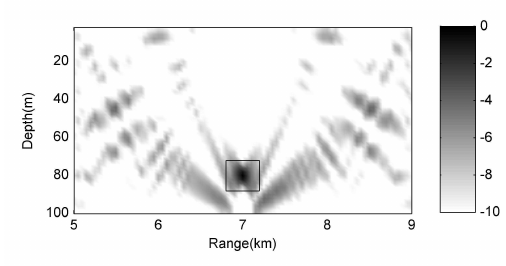
Figure 3. Bartlett ambiguity surface of 1# large array. The target in the rectangle is the localization result, and it is the real acoustic